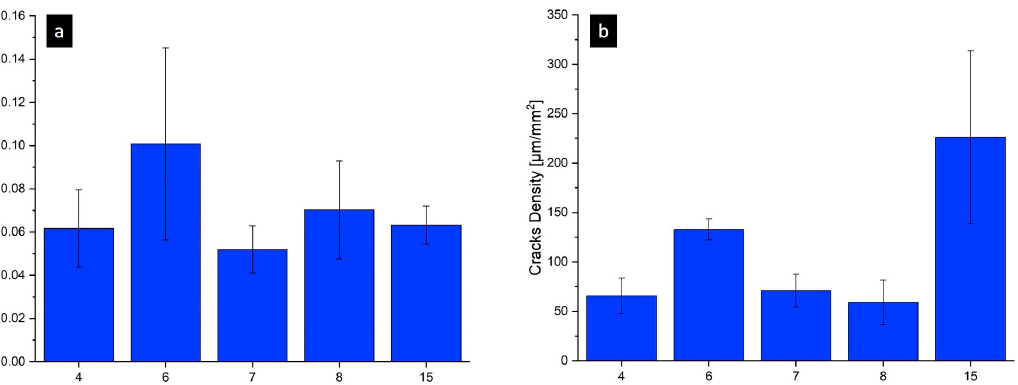
Figure 10. Results of the intra-print repetition assessment: ( a ) pore fraction and ( b ) crack density. The error bars represent the standard deviation of the three mean values calculated for each set in the same print.